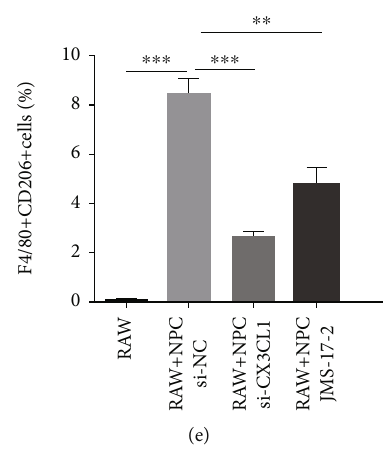
Figure 8: Three siRNAs were designed. It turned out that the siRNA-3 (named si-CX3CL1) showed the highest e ffi ciency and was selected for the further experiment (b). si-CX3CL1 and JMS-17-2 signi fi cantly suppressed the M2 polarization of RAW264.7 induced by NPC as measured by immuno fl uorescent staining (a, c) and fl ow cytometry (f, e). “ ∗∗∗ ” indicates p < 0 : 001 , “ ∗∗ ” indicates p < 0 : 01 . RAW: RAW264.7 macrophages. NPC: nucleus pulposus